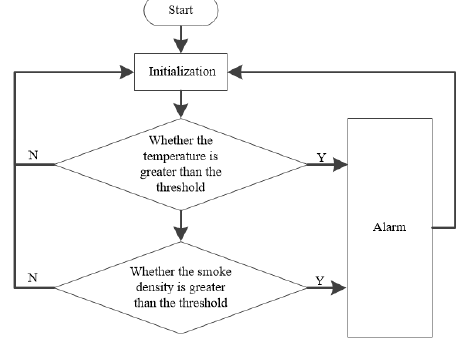
Fig. 11 . The software flow chart of the alarm module.